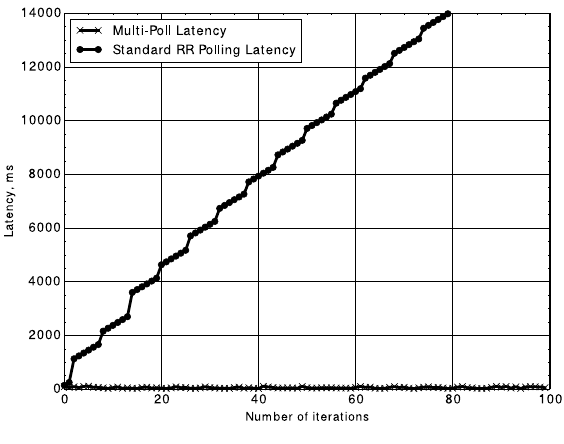
Fig. 6. RTT Fair Realtime Response under